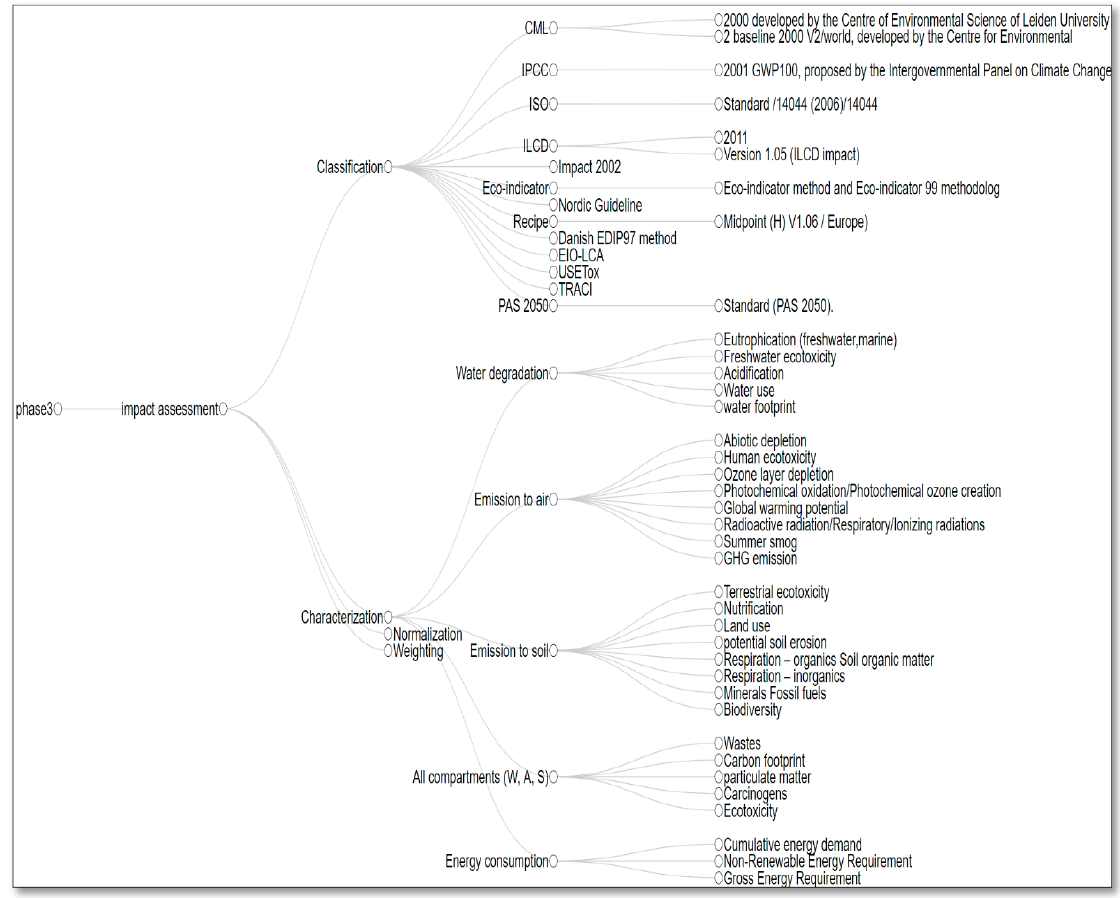
Figure 13. Phase 3 (impact assessment) of life cycle assessment (LCA).